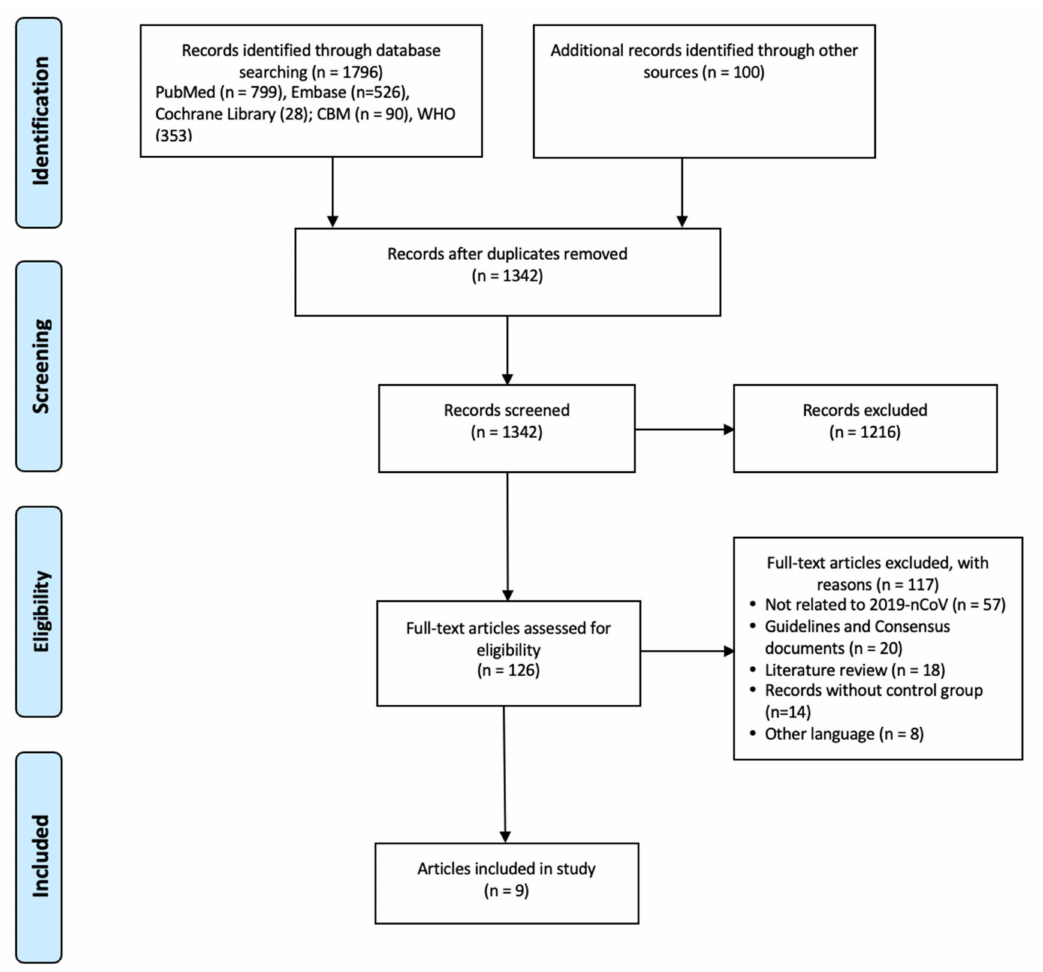
Figure 1. Flowchart of the literature search and